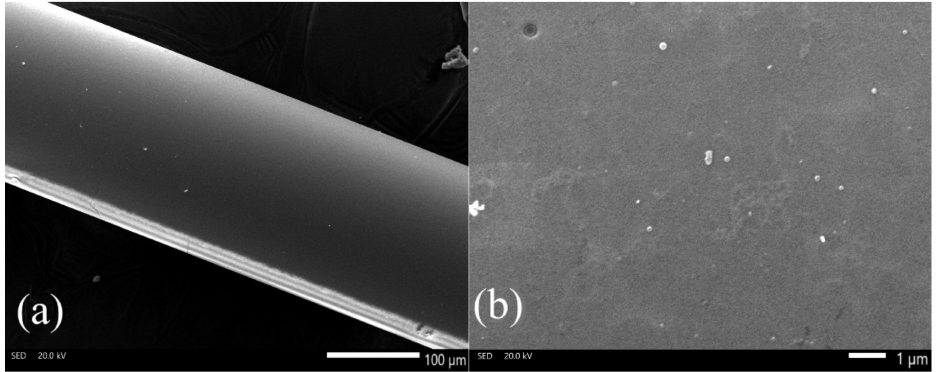
Figure 5. Characterization of fiber samples: ( a )—SEM-image of a cylindrical surface of a taper with a film, ( b )—photograph with high